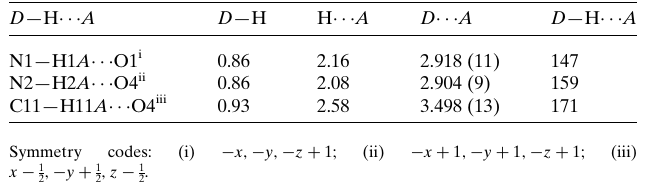
Table 1 Hydrogen-bond geometry (A˚ , (cid:2) ).